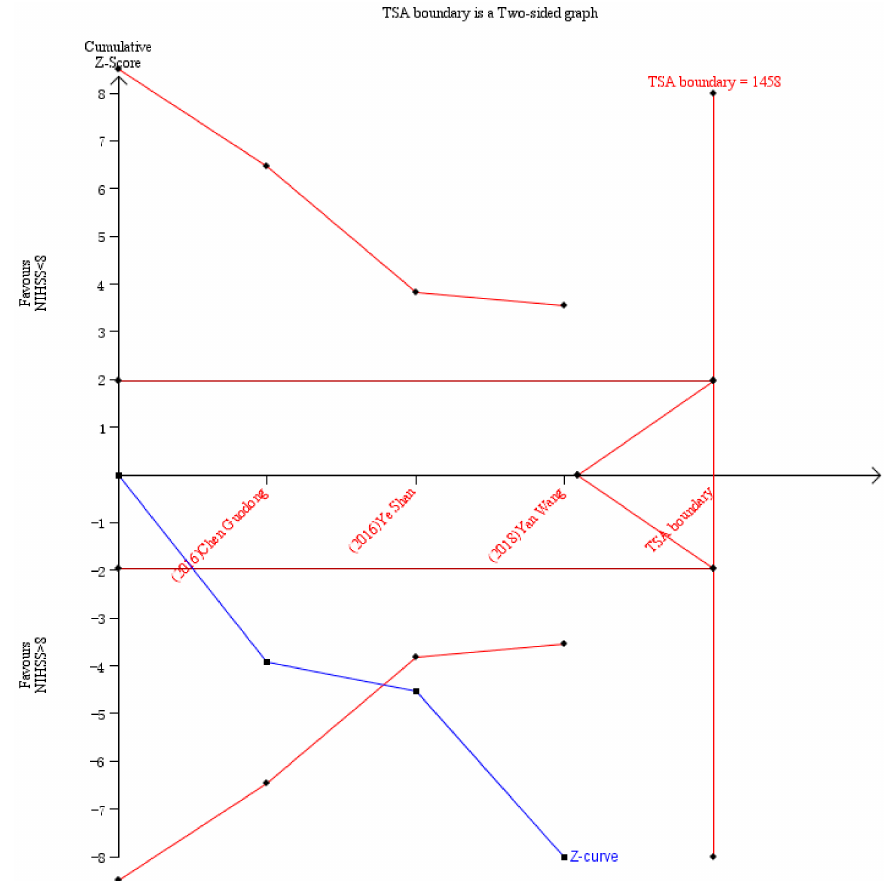
Figure 5. The trial sequential analysis of bilirubin and stroke